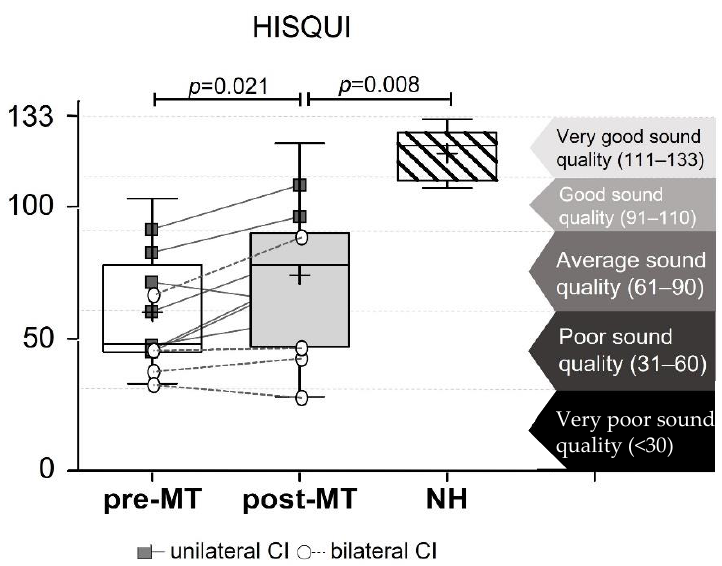
Figure 2. Hearing Implant Sound Quality Index separated into the four sound quality groups, comparing the outcomes before and after Music Therapy.